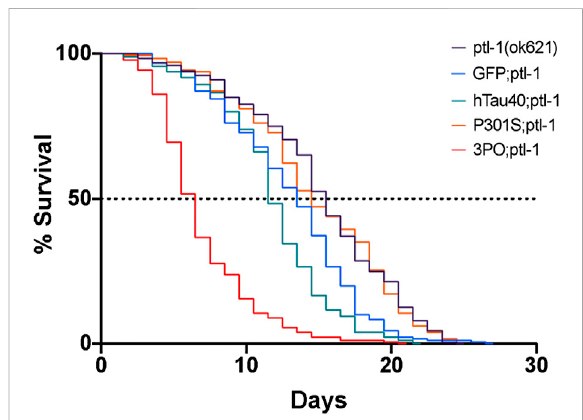
FIGURE 8 Lifespan of ptl-1 mutants expressing human tau. Animals were monitored daily for survival. All the lines expressing mutant taudiedprematurely,comparedtothe ptl-1(ok621) single mutants (log-Rank test). We determined the LD50 as follows: 3POGFP; ptl-1 ~5 days,P301SGFP; ptl-1 ~15 days,hTau40GF; ptl-1 ~12 days, and ptl-1(ok621) ~ 13 days. Curves represent 4 independently conducted